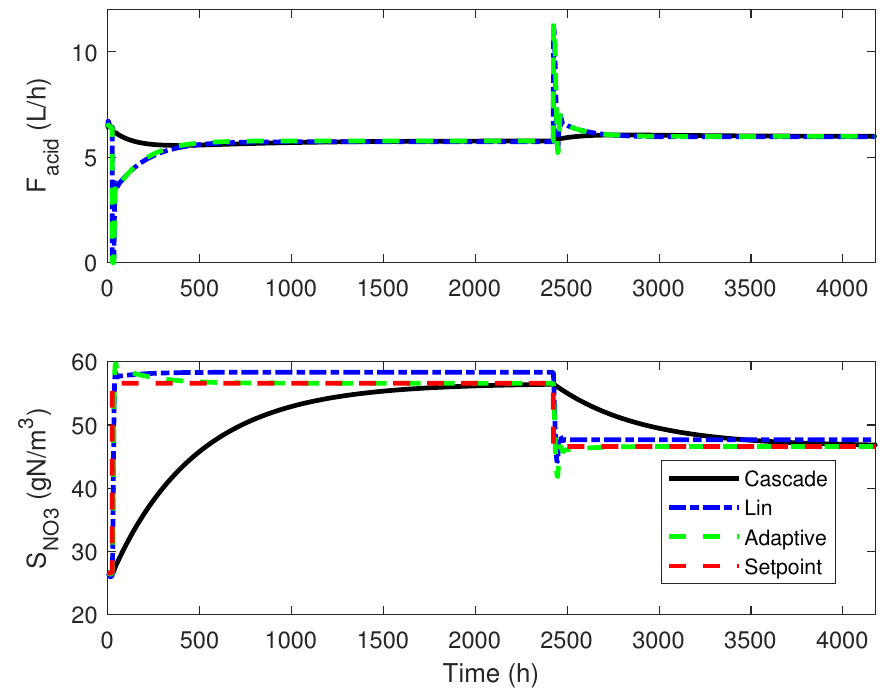
Figure 14. Nitrate concentration and acid flowrate evolutions for a setpoint step variation using different controllers: cascade ( Cascade ), classical linearizing ( Lin ) and adaptive linearizing controllers ( Adaptive